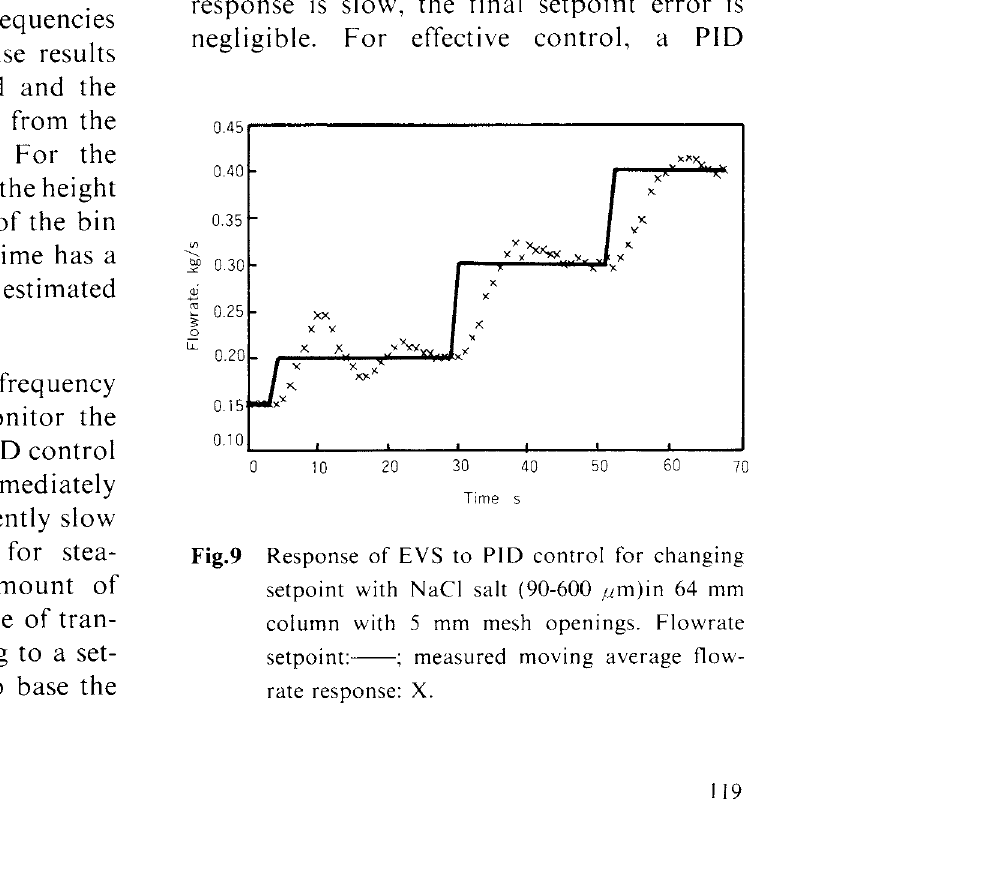
Fig.9 Response of EVS to PID control for changing setpoint with NaCl salt (90-600 11 m)in 64 mm column with 5 mm mesh openings. Flowrate setpoint:--; measured moving average flow rate response: